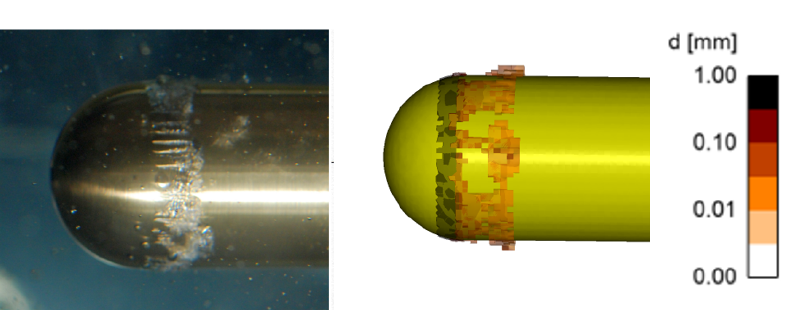
Figure 21. Cavitation near the hemispherical head of the cavitator. Photograph from experiments ( left ); snapshot of the CFD simulations using EE multiphase flow model showing an iso-volume of α g coloured by d gas ( right ).